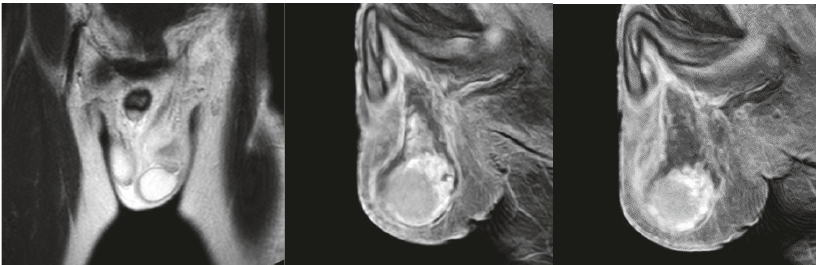
Figure 3: MRI of the scrotum which confirms the presence of hematoma. There is no contrast enhancement of the